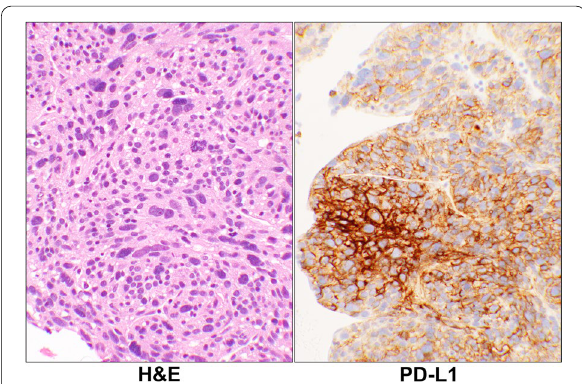
Fig. 5 Metastatic Leiomyosarcoma. H&E stain of a case of metastatic leiomyosarcoma with pleomorphic cells (case# 57, Additional Table 1). The corresponding PD-L1 IHC stain showed 90% positivity of the tumor cells with an intensity of 3